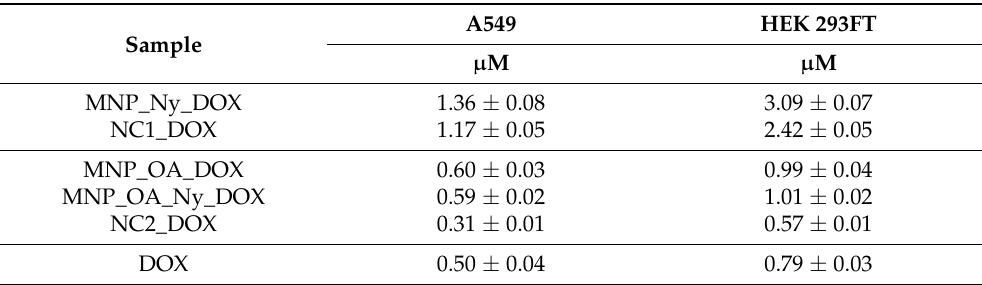
Table 5. The IC50 values of DOX-loaded nanocomposites and nanocapsules for A549 and HEK 293FT cell